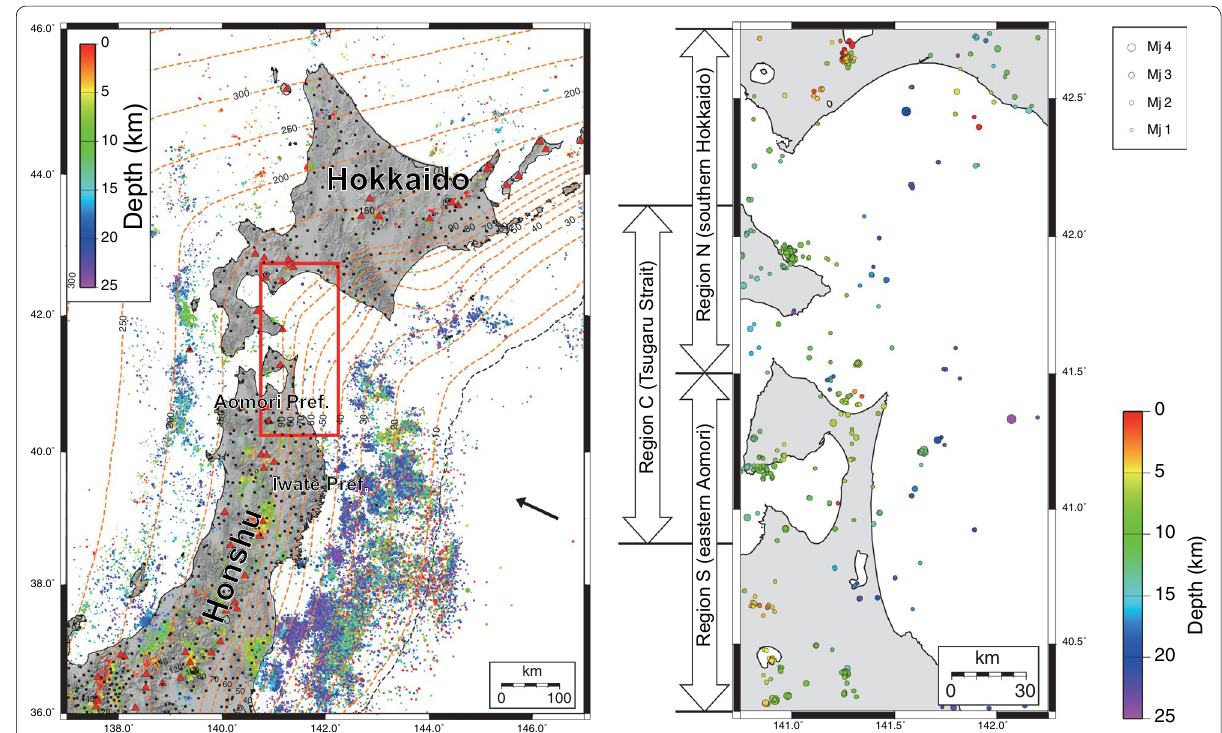
Fig. 1 Tectonic setting and hypocenter distribution in and around the study area. (Left) Hypocenter distribution in NE Japan. The red rectangle indicates the location of the study area shown in the right-hand panel. Thin broken black and orange lines show the position of the Japan trench and depth contours (in km) for the upper surface of the Pacific slab, respectively (Nakajima and Hasegawa, 2006; Kita et al. 2010). The arrow shows the direction of plate motion of the Pacific plate relative to the Okhotsk plate (Wei and Seno 1998). Red triangles denote active volcanoes. Circles denote hypocenters determined by JMA (3 June 2002 to 31 December 2017). (Right) Hypocenter distribution in the study area, with hypocenter depth shown by the color scale. The northern and southern parts of the study area are referred to as “region N” (southern Hokkaido) and “region S” (eastern Aomori), respectively. The region combining the southern half of region N and the northern half of region S is referred to as “region C” (Tsugaru